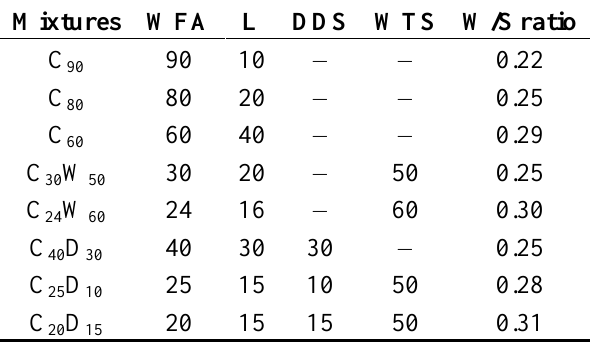
Table 1. Artificial aggregates compositions, wt